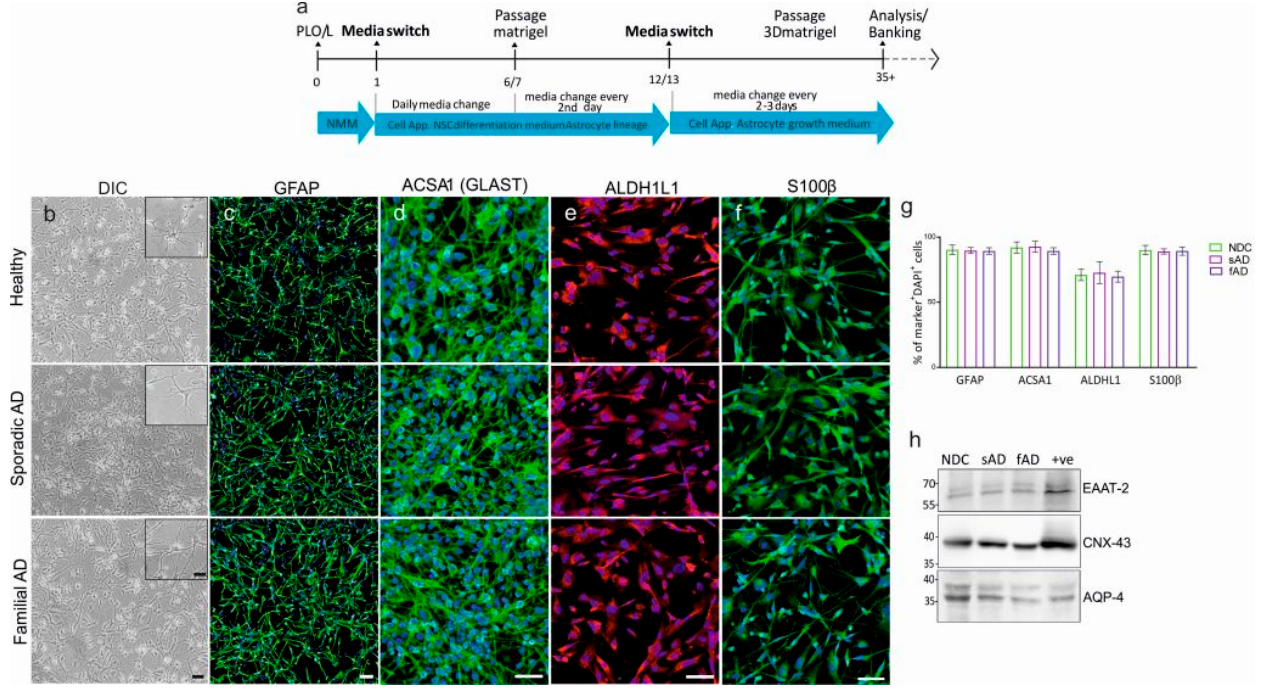
Figure 1. Differentiation of astrocytes from iPSC-derived neuronal stem cells from non-demented control, sporadic and familial Alzheimer’s disease. ( a ) Scheme showing differentiation of astrocytes from iPSC-derived NSCs. ( b ) Phase contrast images of astrocyte monolayer after 30 days of induction. Scale bar: 50 µm; inset: 20 µm. No prominent morphological difference in astrocytes was observed between the three groups. Representative images of markers for astrocytes differentiated from non-demented control, sporadic and familial iPSC-derived neuronal stem cells using antibodies against ( c ) GFAP, ( d ) ACSA 1, ( e ) ALDH1L1, and ( f ) S100 β . DAPI was used for nuclear visualization. Scale bar: 50 µ m. ( g ) Graph showing percentage of cells positive for individual markers in ( c – f ). One-way ANOVA followed by Tukey’s multiple comparisons tests. ( h ) Immunoblots of astrocyte cell lysates after differentiation using antibodies against astrocyte markers EAAT-2, Conexin-43 (CNX-43) and Aquaporin-4 (AQP-4). Human brain cell lysate was used as a positive control (+ve). Results are expressed as mean ± SEM, n = 3/group; n = 3 experimental